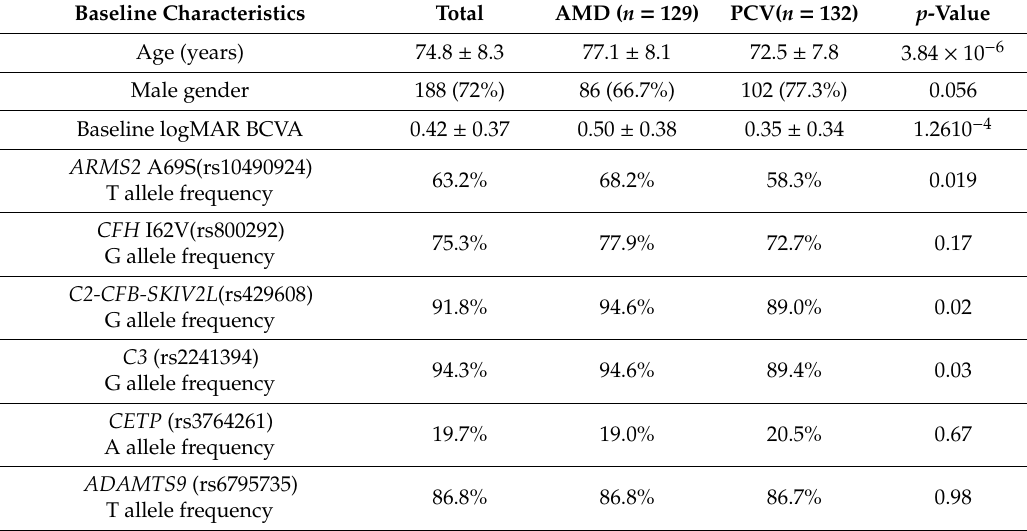
Table 1. Demographic and genetic characteristics of patients with exudative age-related macular degeneration